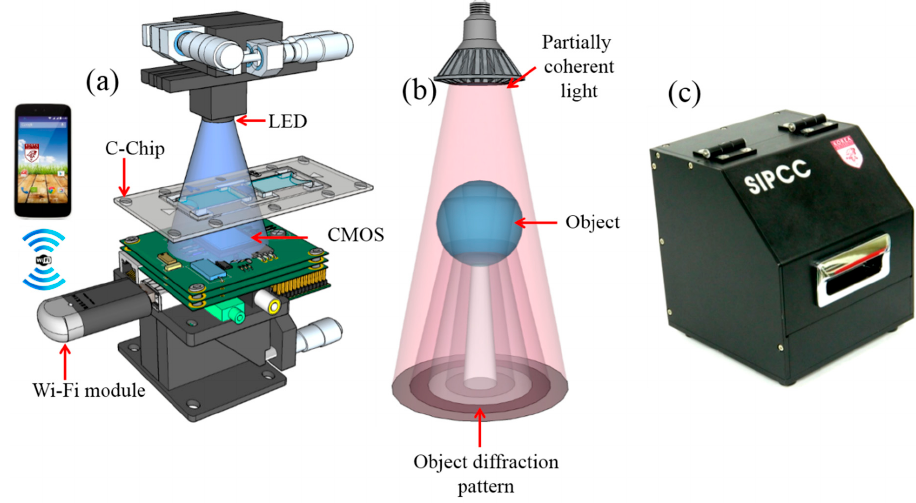
Figure 1. Schematic and working principle of the lens-free imaging system. ( a ) Schematic of the proposed system illustrating its simplicity with potential wireless file transfer facility; ( b ) cartoon of working principle of the formation of the diffraction pattern of a micro-object; ( c ) external view of the fabricated